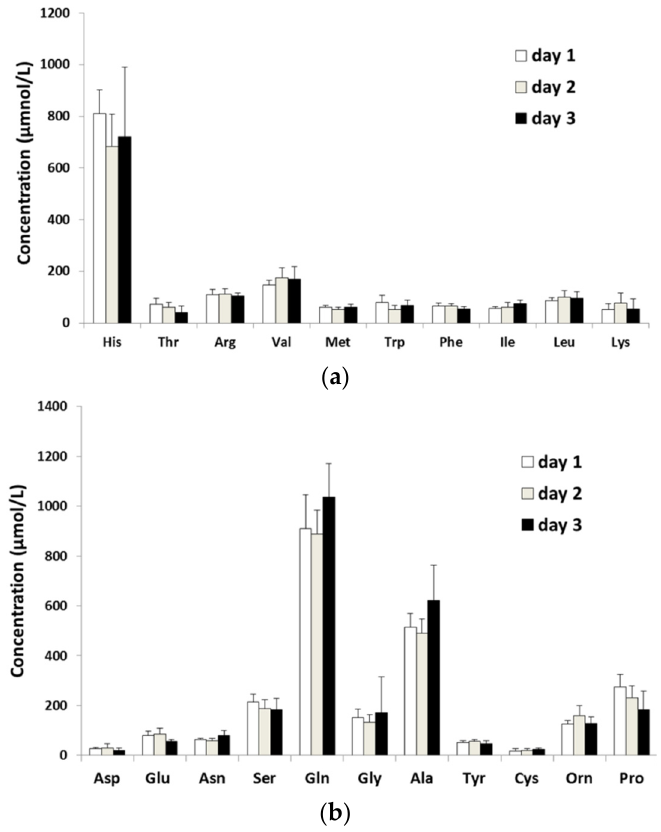
Figure 3. Diurnal fluctuations in AA concentration. Data are shown as mean ± SD. Results for ( a ) essential and ( b ) non-essential AAs are shown.